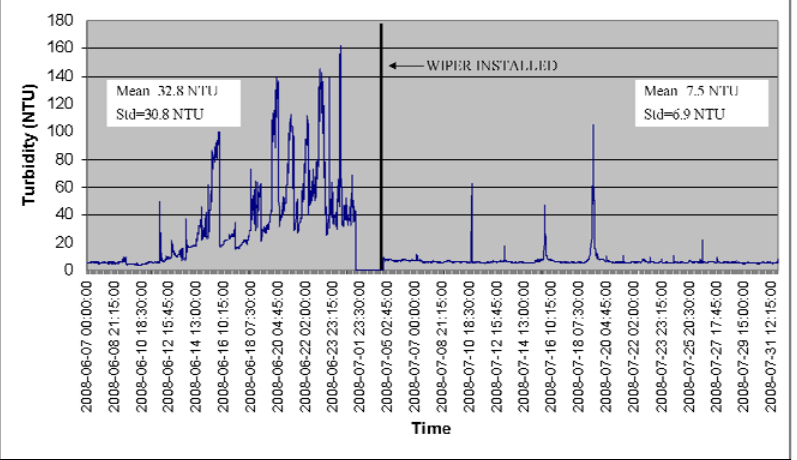
Figure 7. An example of the effect of a turbidity wiper installed to one of the SoilWeather WSN's turbidity sensors. Turbidity measures a month before and after the wiper has been installed. The mean and standard deviation before and after